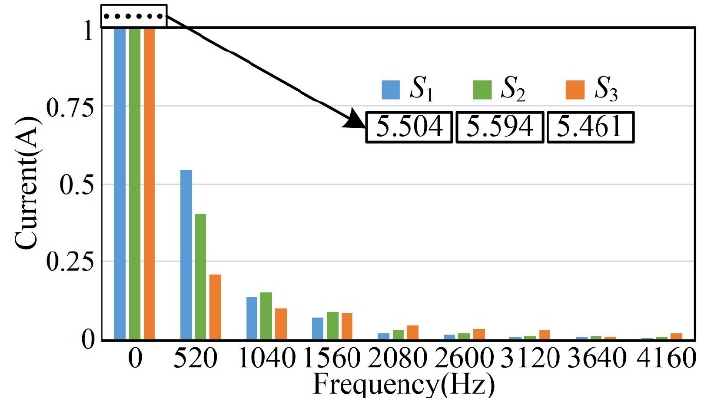
Figure 16. Equivalent current spectrum diagram of S 1 , S 2 and S 3 under condition 2. The harmonic component of commutation torque ripple of BLDC motor is mainly concentrated in the frequency of 6 k th harmonics (k = 1, 2, 3, . . . ) [30]. Therefore, the proposed control strategy can also suppress the commutation ripple. Hence, condition 2 is selected for motor commutation analysis, and the Figure 17 is the current vector trajectory diagram of S 1 , S 2 and S 3 . Obviously, the current vector trajectory changes from irregular sawtooth shape to standard regular hexagon, which can reduce the commutation torque ripple